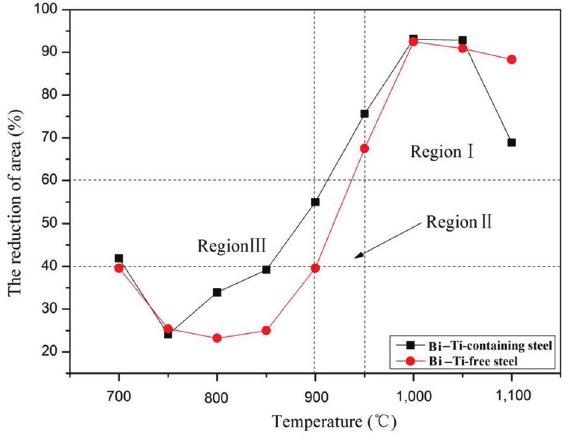
Figure 3: Hot ductility curves of the steel samples A and